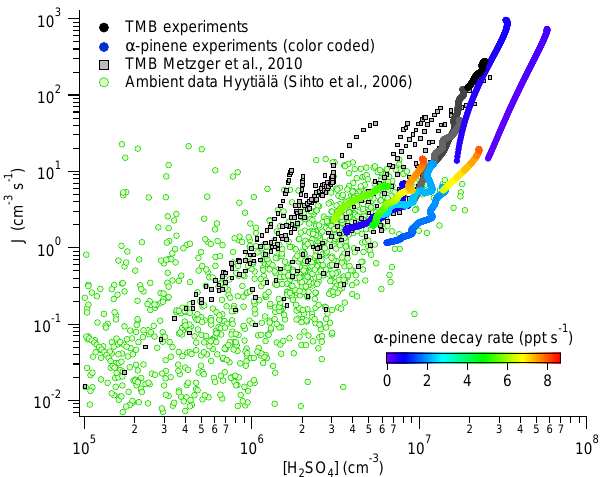
Fig. 4. Colored symbols represent the particle formation rates cal- culated with the PSM as a function of the sulfuric acid concentra- tion. The α -pinene experiments are color coded with the α -pinene decay rate. For comparison we plot the TMB data from Metzger et al. (2010) (gray squares) and ambient data measured in Hyyti¨al¨a (green circles, Sihto et al., 2006).